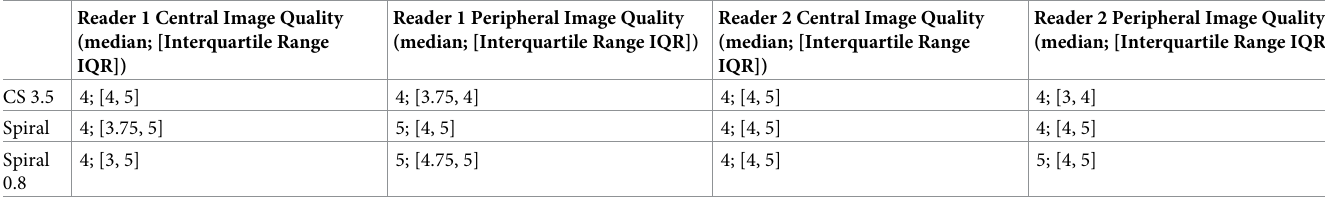
Table 2. Overview of the data from qualitative image quality assessment. Reader 1 Central Image Quality (median; [Interquartile Range